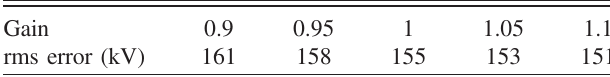
TABLE IV. rms error with feedforward gain (feedback on).